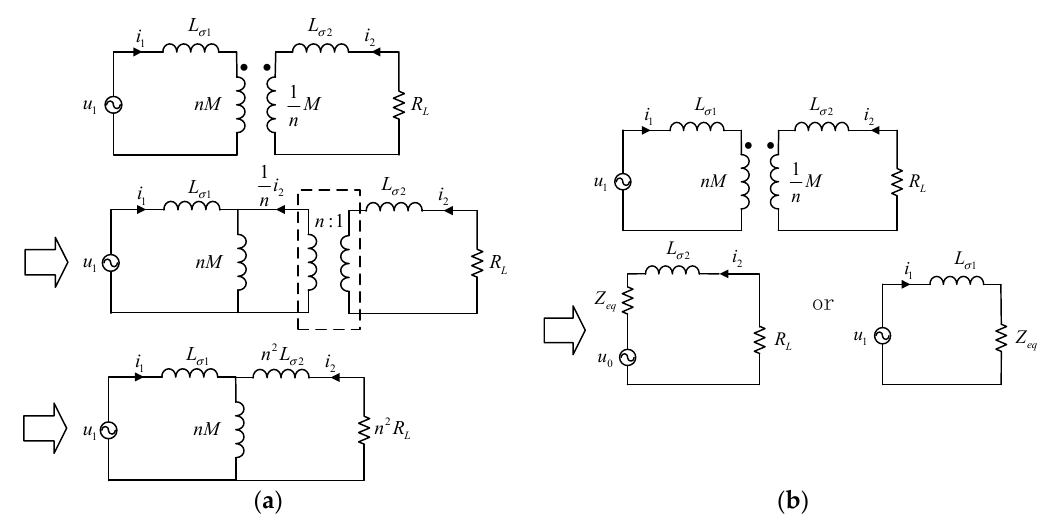
Figure 2. The equivalent circuit. ( a ) The equivalent circuit A; ( b ) The equivalent circuit B.